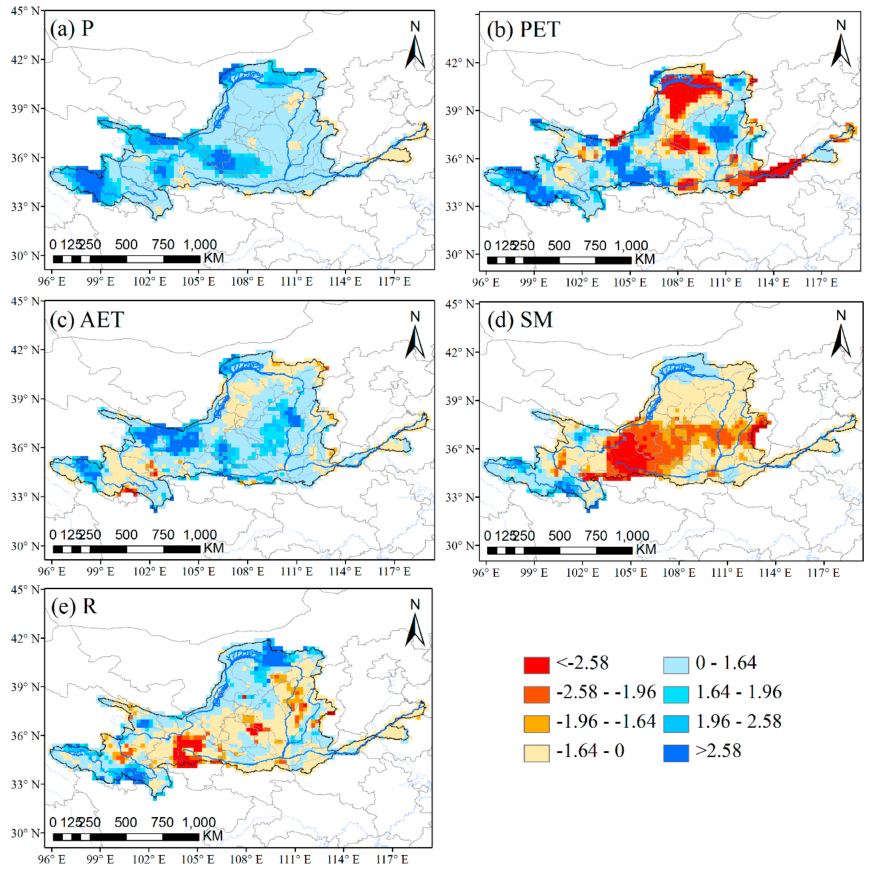
Figure 10. Spatial distribution of the winter trends for five hydrological